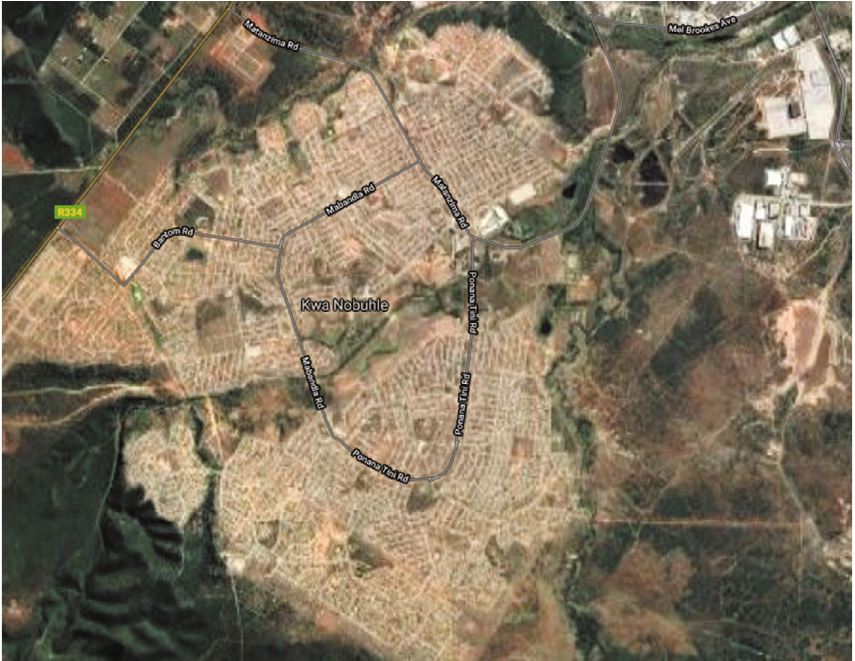
Figure 1: A map depicting the study